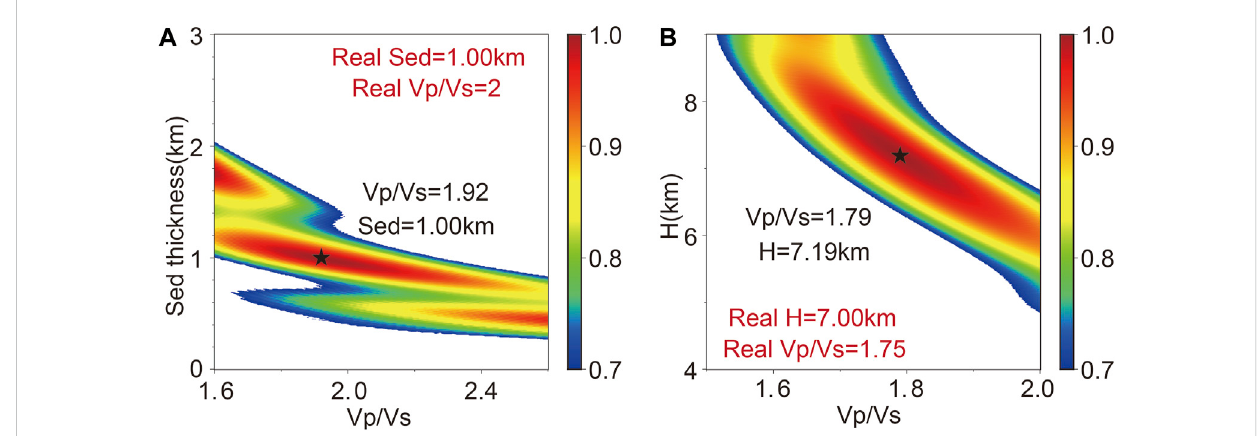
FIGURE 4 SequentialH- κ stackingofsyntheticreceiverfunctionsofthecrustalmodelwithasedimentarylayer. (A) Sedimentarythicknessand (B)